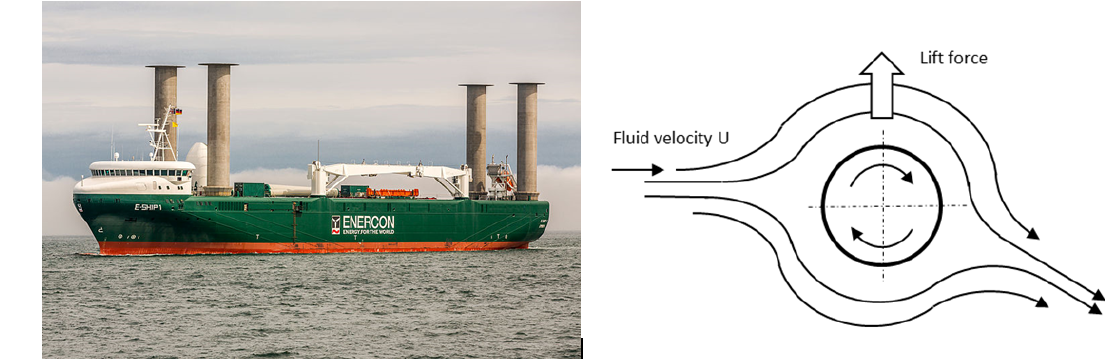
Figure 9. On the left, the E-Ship 1 in 2015. It is fitted with four 27m tall Flettner rotors. Picture by Alan Jamieson. On the right, diagram showing the Magnus effect by which lift is produced by a rotating cylinder.